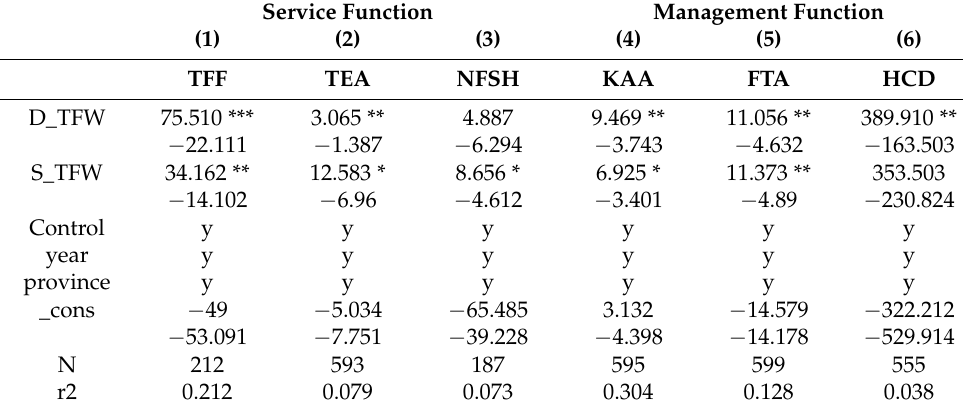
Table 4. Empirical results of functional differences in TFW under different management systems. Service